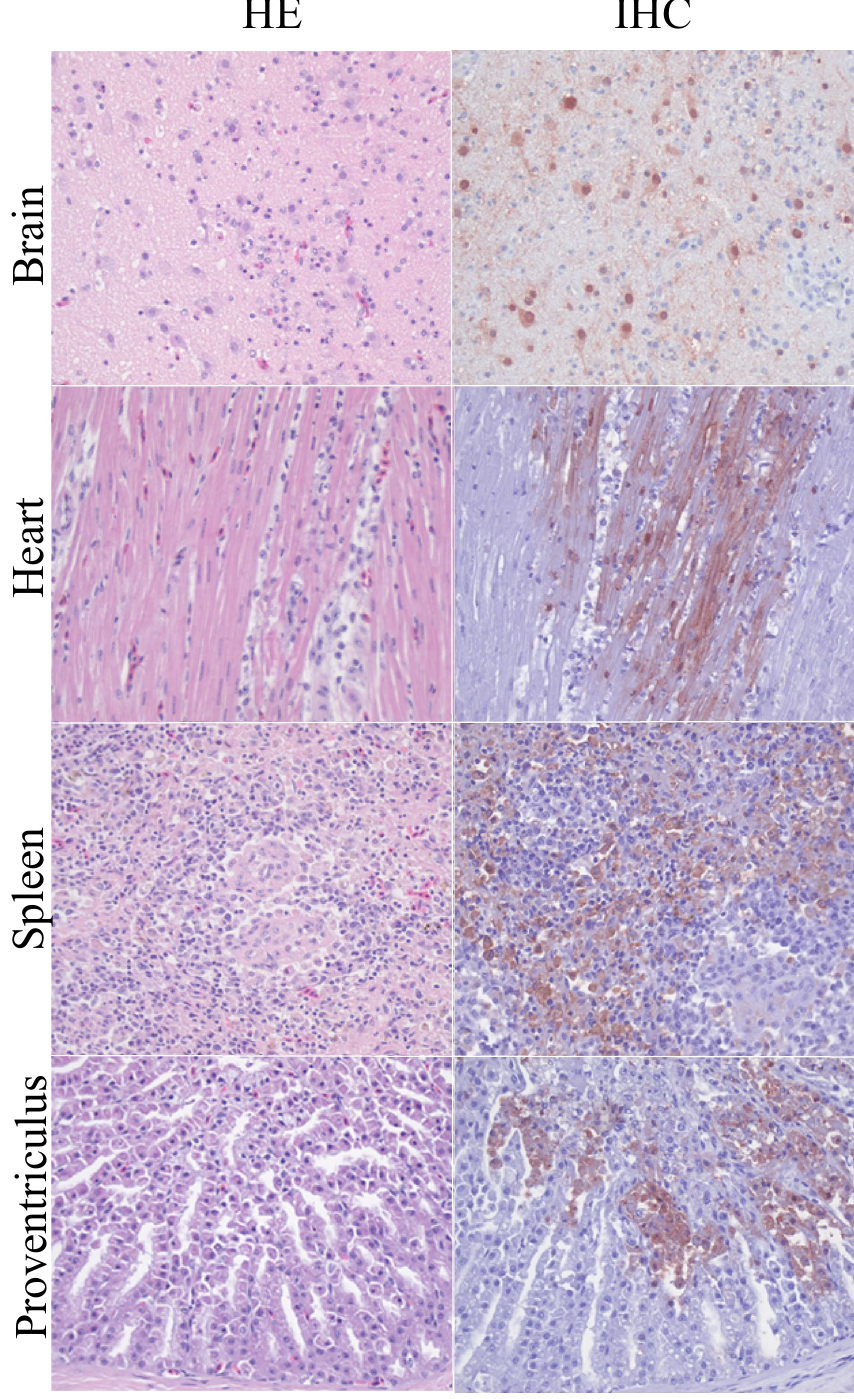
Figure 1. Histopathological changes and influenza virus antigen expression in tissues of HPAI H5N8 virus- infected Common buzzards ( Buteo buteo ). Tissue sections in the left column are stained with hematoxylin and eosin (HE). Serial tissue sections in the right column are stained for influenza virus antigen by immunohistochemistry (IHC). In all tissues there is necrosis and inflammation associated with virus antigen